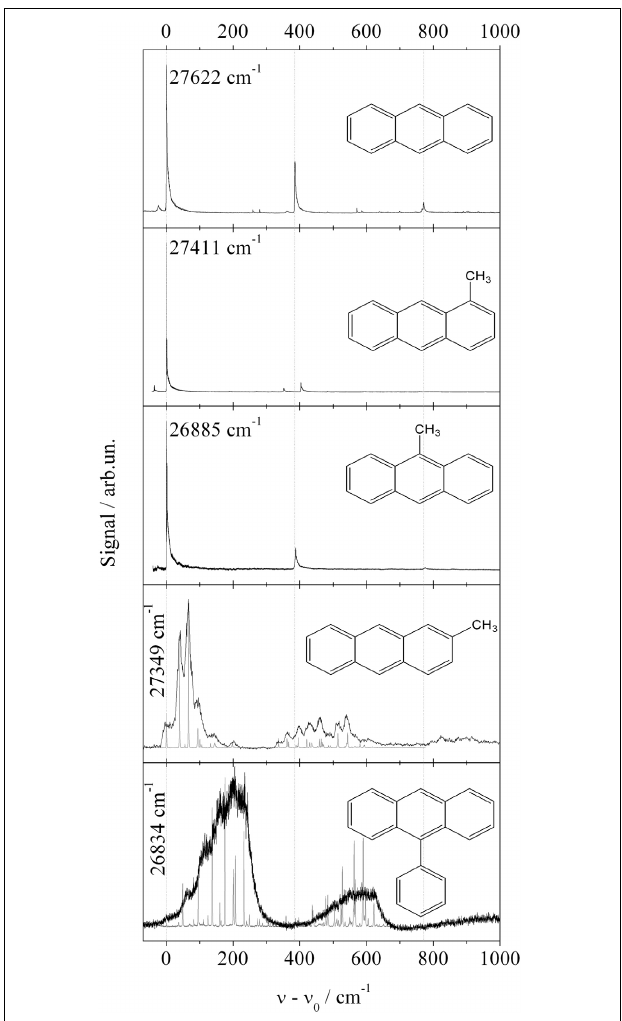
FIGURE 4 | Fluorescence excitation spectra of fife Anthracene derivatives as indicated in each panel. Vertical dashed lines indicate basic vibronic transitions present for all derivatives. Torsional mode progressions resolved for 2-MA and 9-PA in the gas phase (gray line) are damped in helium droplets (black